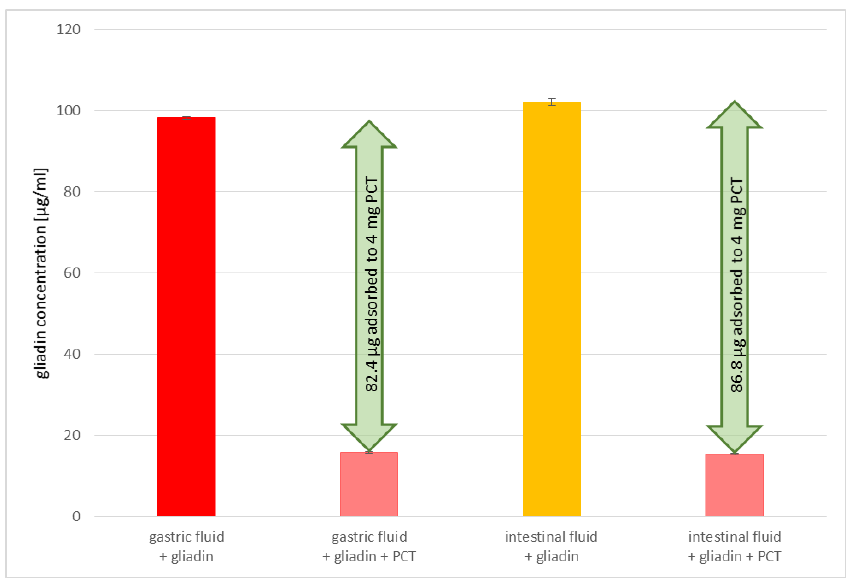
Figure 4. Gliadin bound to purified clinoptilolite-tuff in artificial fluids. Gliadin solutions were mixed with gastric or intestinal artificial fluids with and without PCT and analyzed by ELISA. Both approaches revealed adsorption capacities higher than 20 µg/mg gliadin to PCT.